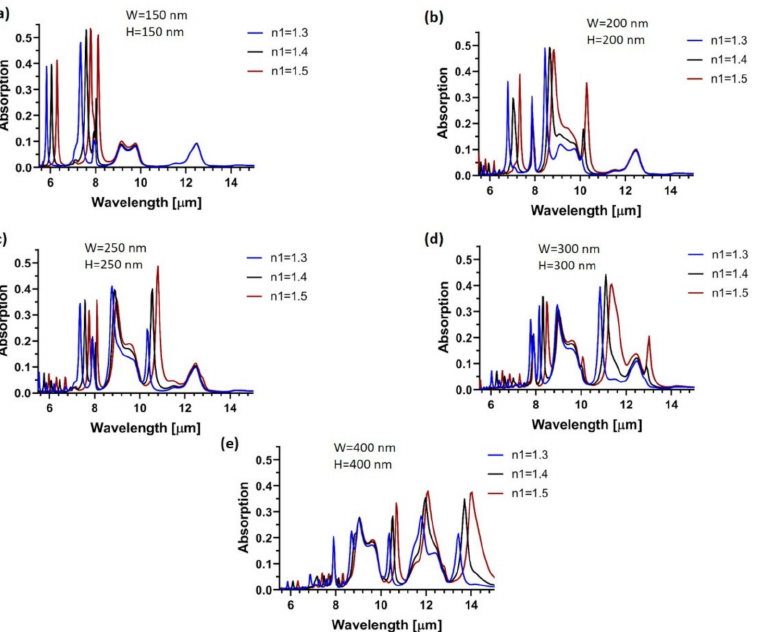
Figure 4. Geometry dependence of the plasmonic resonance shifts in biaxially crumpled graphene structures supported on the PDMS substrate with aspect ratio W/H = 1 for ( a ) W = H = 150 nm, ( b ) W = H = 200 nm, ( c ) W = H = 250 nm, ( d ) W = H = 300 nm, and ( e ) W = H = 400 nm. The RI of sample n 1 varies from 1.3 to 1.5. The electronic properties of graphene are set as E f = 0.64 eV and µ = 10,000 cm 2 /(V ·